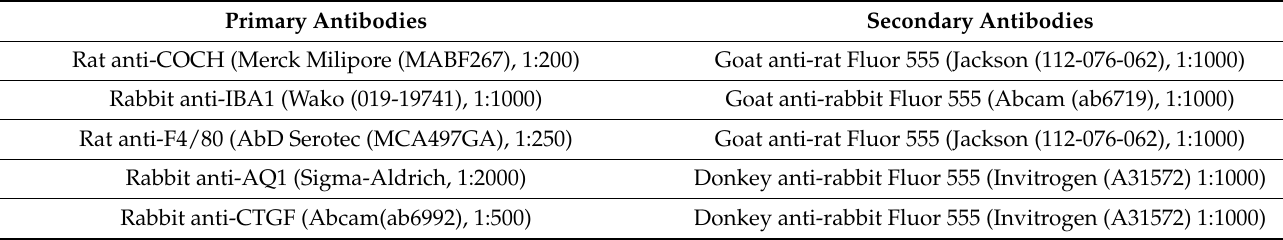
Table 2. Overview of antibodies used to stain the spiral ligament. Primary Antibodies Secondary